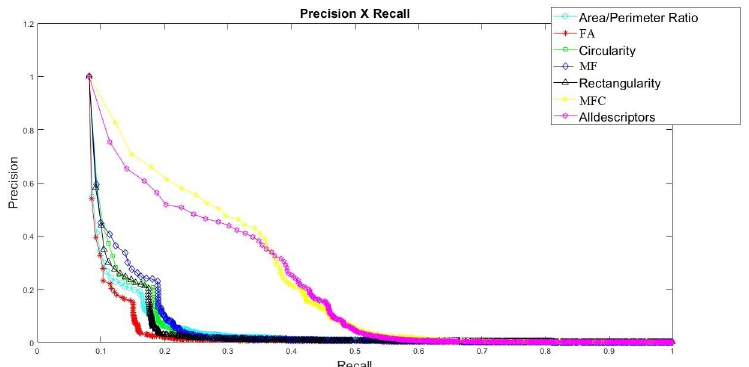
Fig 3. Representation of retrieved performance results in relation to the precision x recall curve for all evaluated descriptors. Abbreviations: FA = Fractal Area, MF = Maximum Fractal, MFC = Multiscale Fractal Curve.